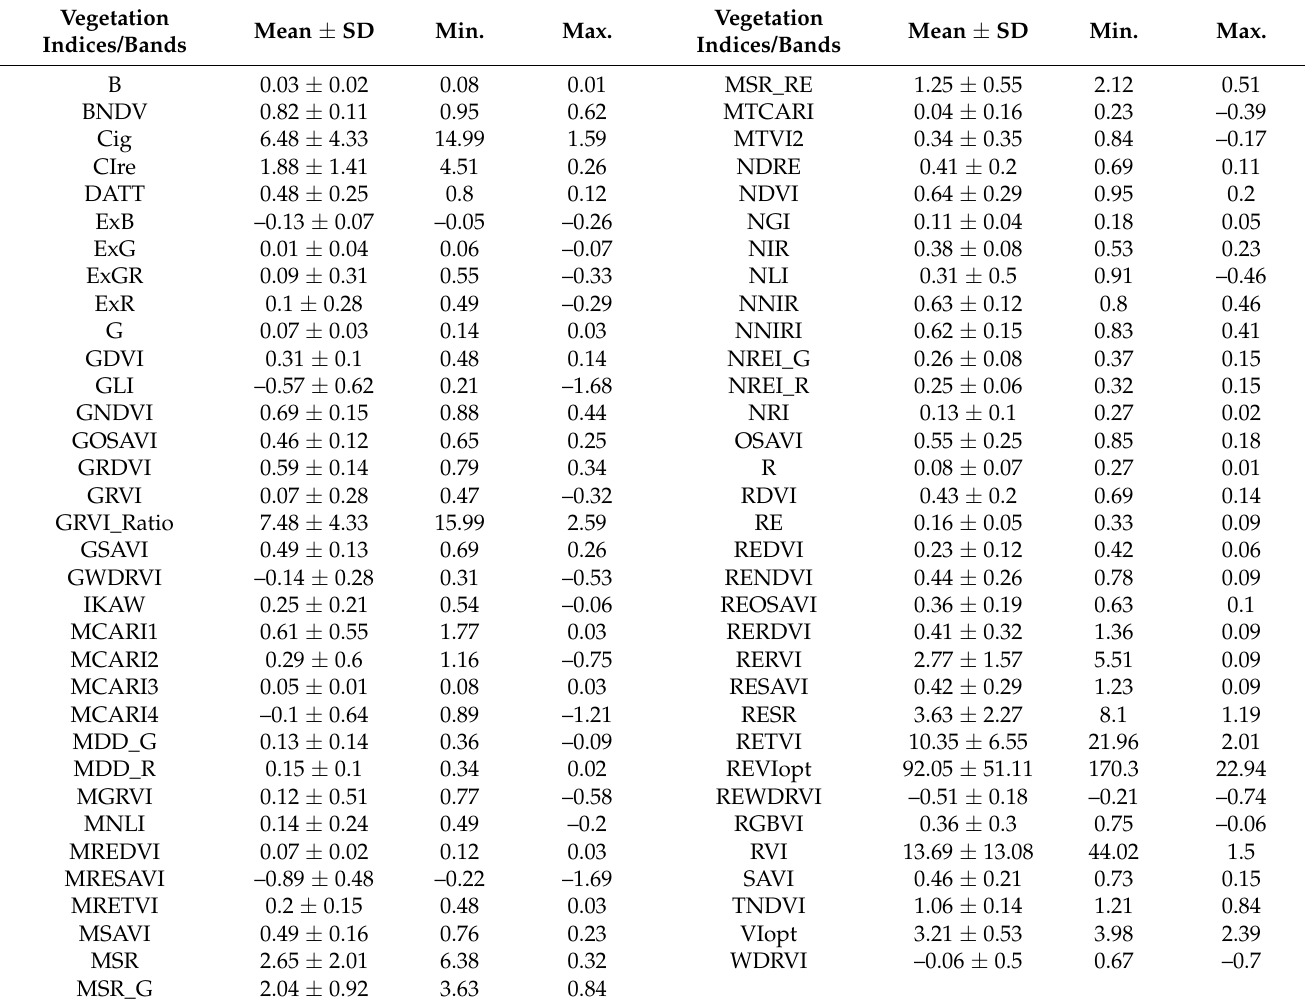
Table A2. Mean, standard deviation, minimum, and maximum values of vegetation indices used in the study.